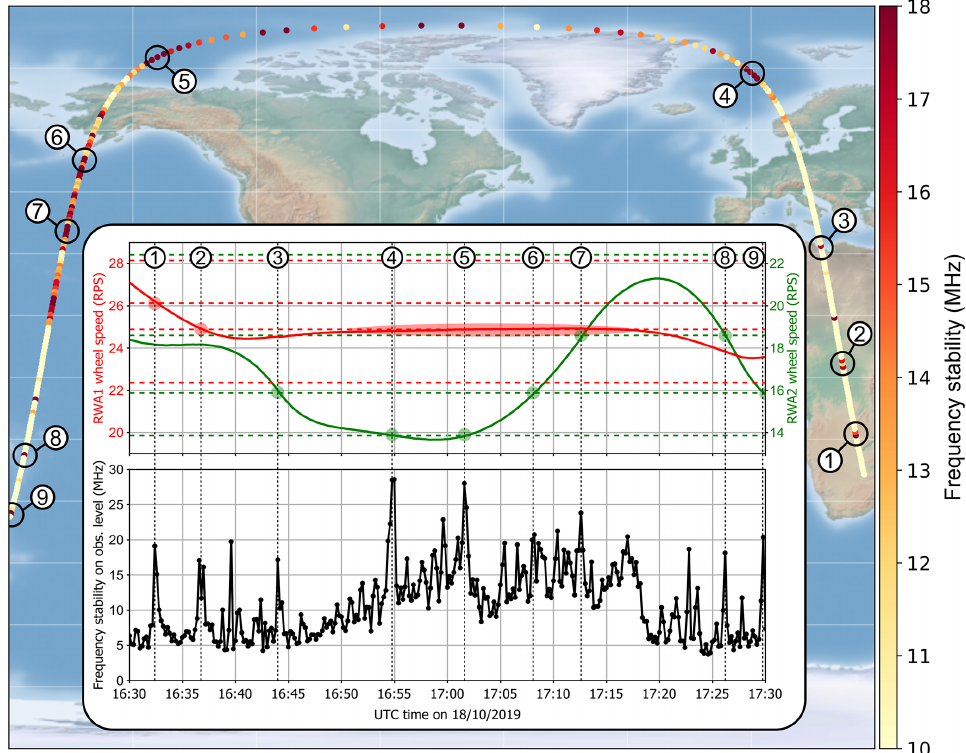
Figure 10. Geolocation of observations with enhanced laser frequency variations and their relation with the reaction wheel speeds of RWA 1 and RWA 2 in the period from 16:30 to 17:30UTC on 18 October 2019. Each dot on the map corresponds to one observation, whereby the color coding describes the frequency stability in terms of σ f (N = 540 ) . The inset depicts the temporal evolution of the RWA 1 (red) and RWA 2 (green) wheel speeds in the top panel together with the frequency stability per observation. Dashed horizontal lines in the top panel indicate the most critical wheel speeds that were determined for the analyzed week in October 2019 (see Table 3). Additional peaks in the frequency stability are related to other critical frequencies which are not listed in Table 3 but visible in Fig.